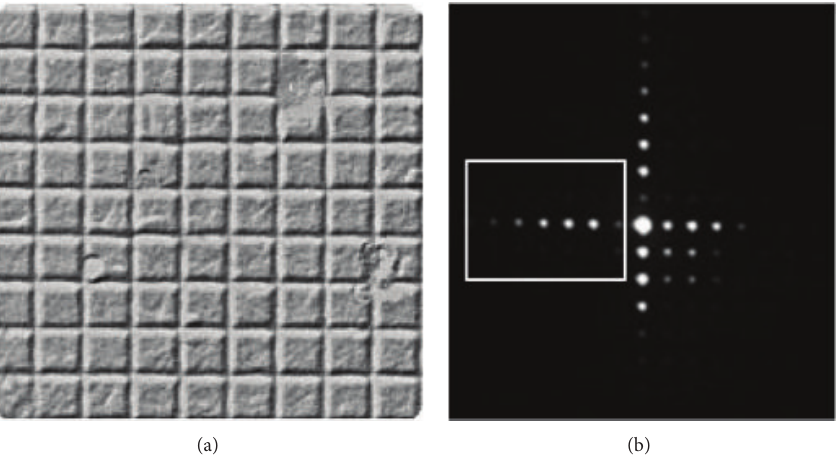
Figure 30: Typical diffraction grating image and a low-angle diffraction pattern: the white box enhances the portion of the pattern measured via the sensor.